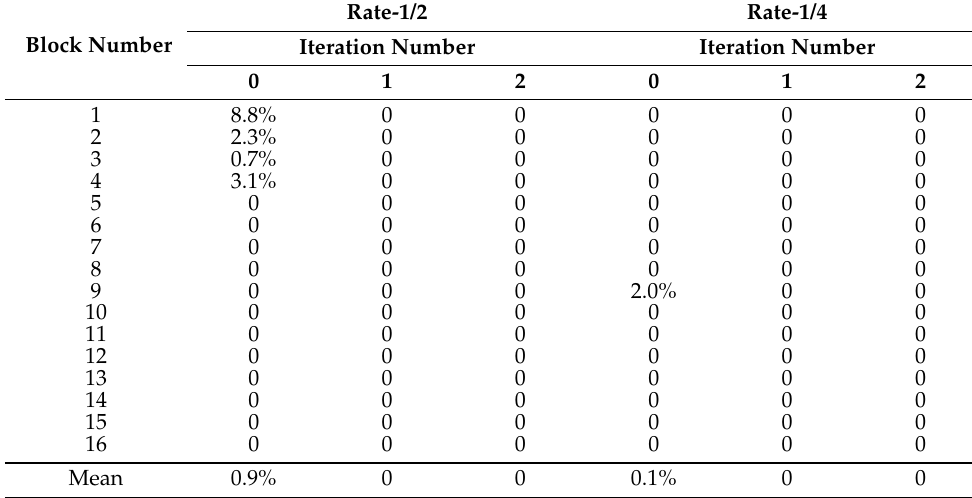
Table 5. BER performance of the GL turbo system with S256 at SNR = 13 dB for Yellow Sea